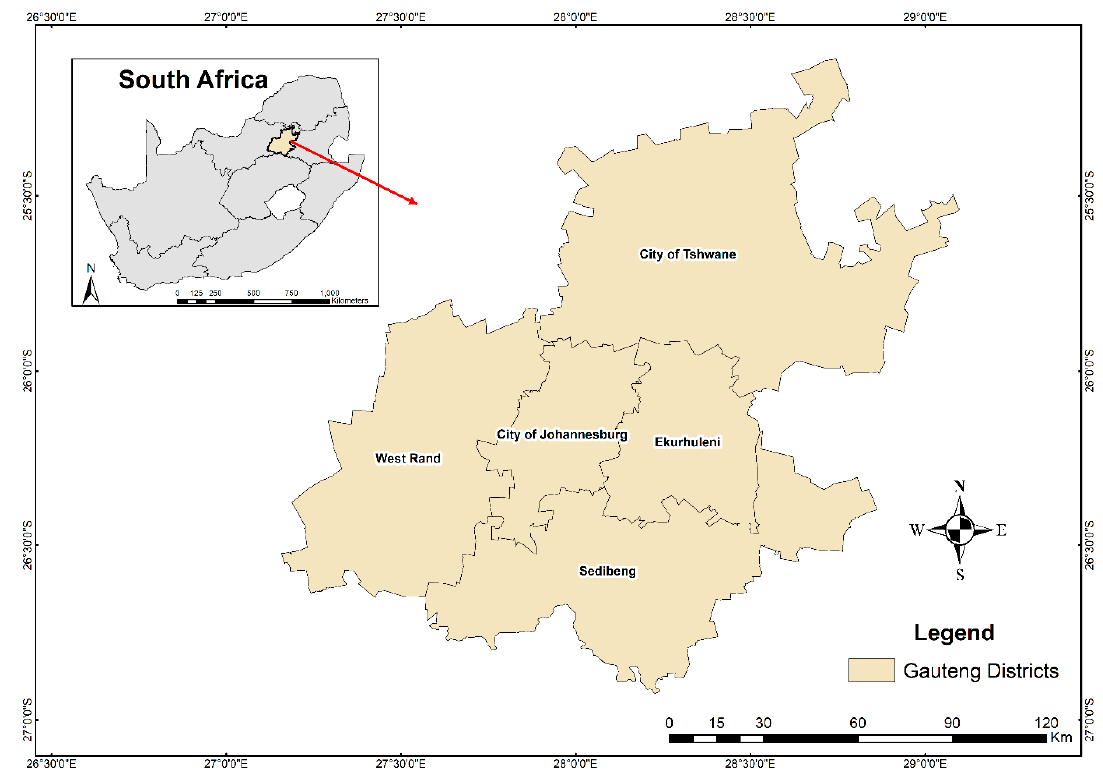
Figure 1. Map of Gauteng showing the five districts.